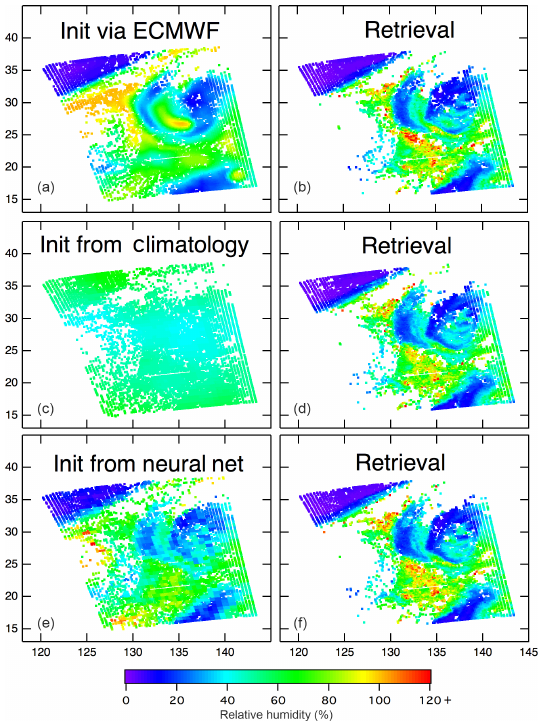
Figure 11. AIRS-OE relative humidity (calculated from retrieved temperature and water vapor) at 321mb using different a priori data. Panels (a) , (c) , (e) show the relative humidity calculated from the a priori data, while (b) , (d) and (f) show the retrieval. Panels (a) and (b) uses an ECMWF analysis-derived a priori data linearly in- terpolated in time, space and log pressure to the AIRS observation. (c) and (d) uses a climatology. Panels (e) and (f) uses the neural- net calculation (on the AIRS-AMSU footprint) that is used with the operational AIRS V6 retrieval. Note that while the different a priori data were used for temperature, skin temperature and water vapor, the same MODIS-derived cloud data (cloud-top temperature, cloud optical depth and cloud particle radius) were used as a priori data for the cloud retrievals.